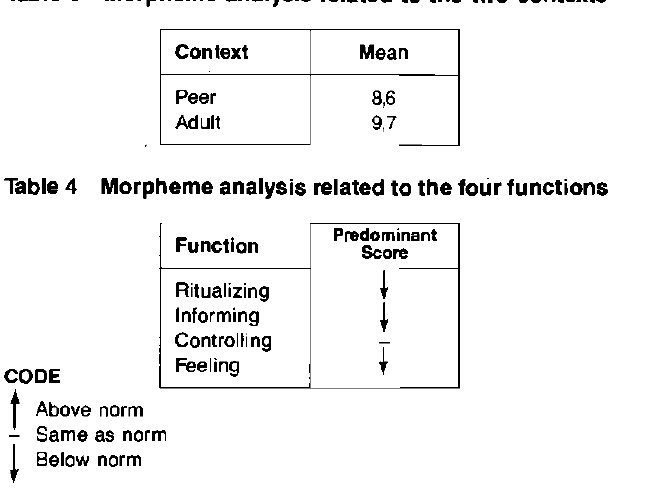
Table 8 Stuttering analysis using predominant scores related to the two